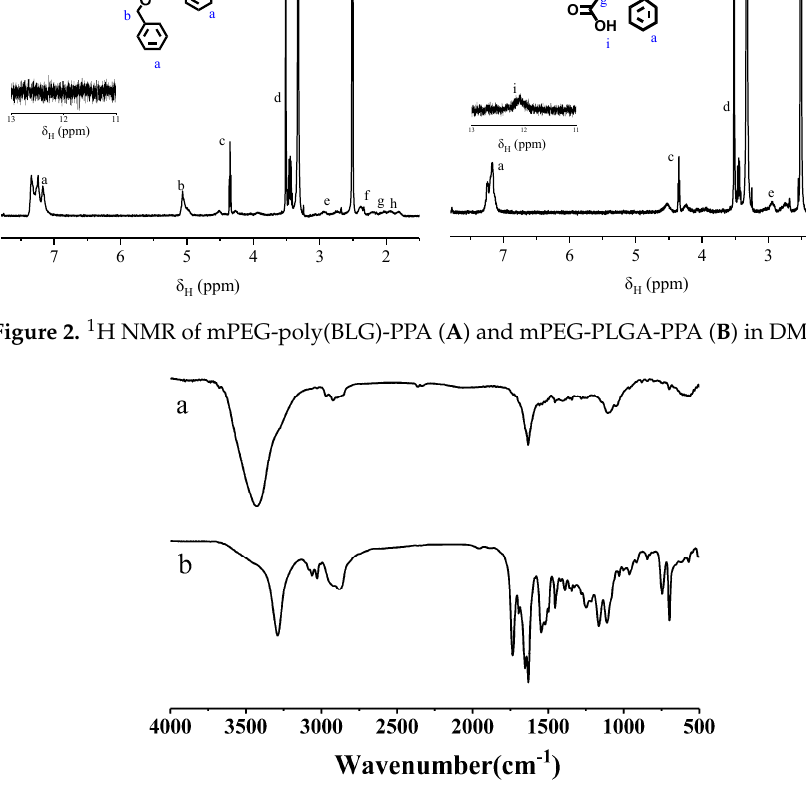
Figure 3. FT-IR spectra of copolymer mPEG-PLGA-PPA (a) and mPEG-poly(BLG)-PPA (b).